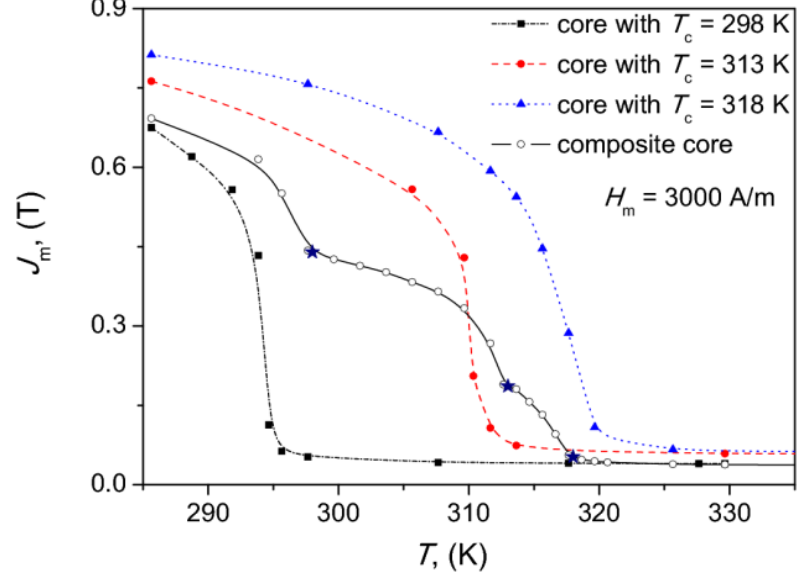
Figure 5. The measured J m vs. T dependencies for the examined composite core.